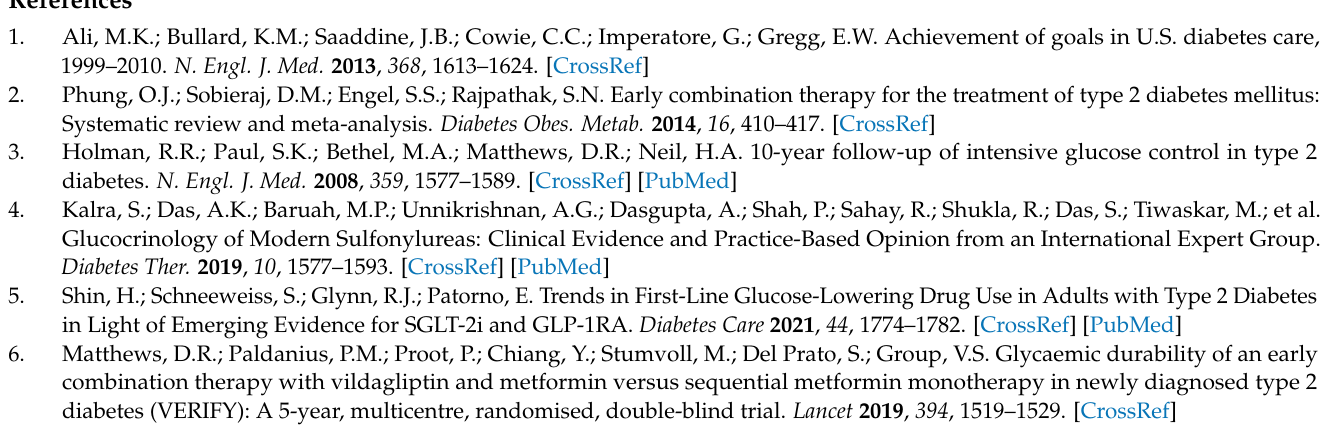
intervention; Figure S2: Trial outline; Figure S3: Changes in microbiota profiles of bacterial genera with gemigliptin–metformin or glimepiride–metformin combination therapies during the study period; Figure S4: Profiles of gut microbiota related to clinical outcomes according to the treatment group; Figure S5: Heatmap of the Pearson’s correlation analysis between clinical parameters and the microbiota; Figure S6: Predicted functional composition of metagenomes based on the 16S rRNA gene sequencing data of the gemigliptin–metformin and glimepiride–metformin treatment. Heatmap of Kyoto Encyclopedia of Genes and Genomes (KEGG) pathways identified as changes of pathways with between-group differences; Figure S7: Heatmap of the Pearson’s correlation analysis between clinical parameters with changes in amino acids; Table S1: Changes in amino acids at the baseline